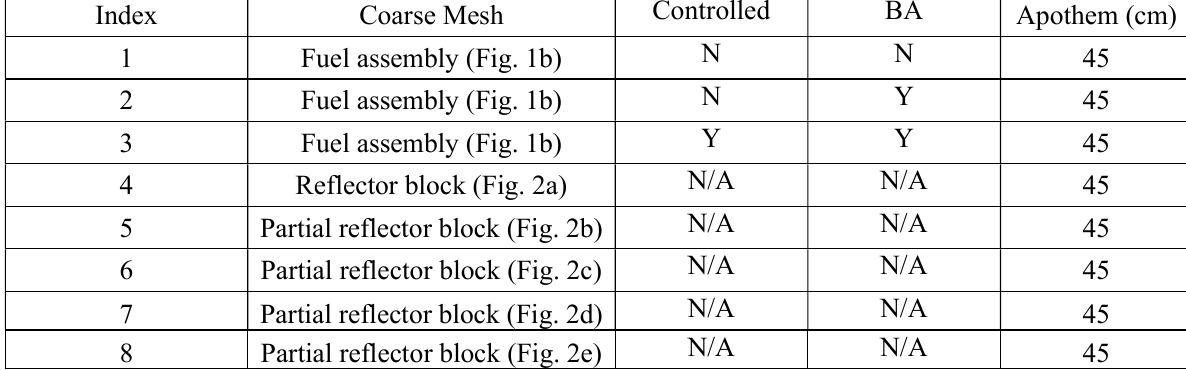
Table I. Dimension and property of unique coarse meshes.